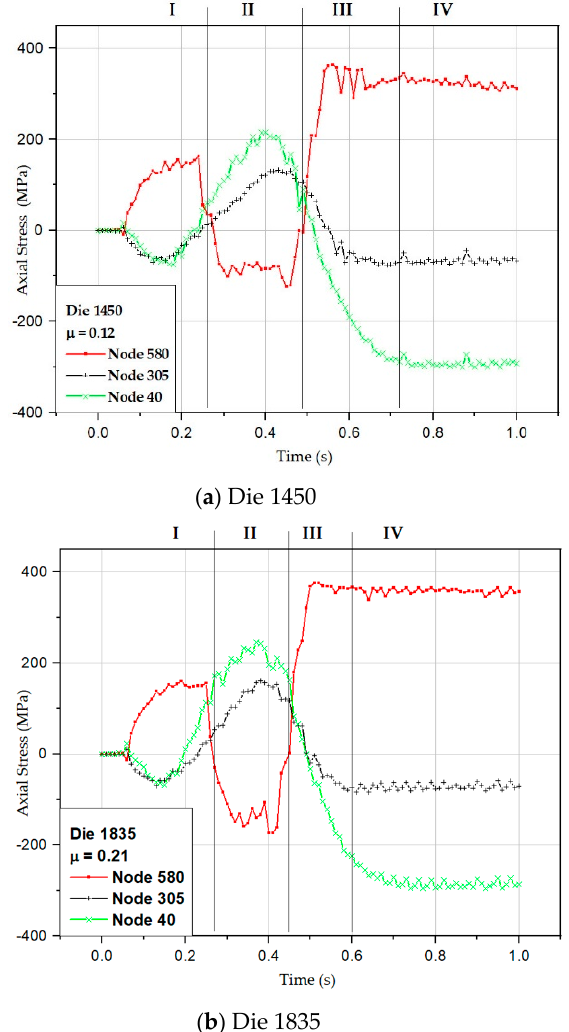
Figure 5. Axial stress as a function of time for the three nodes 580, 305, and 40. The calculations are carried out for the dies 1450 ( a ), and 1835 ( b ).